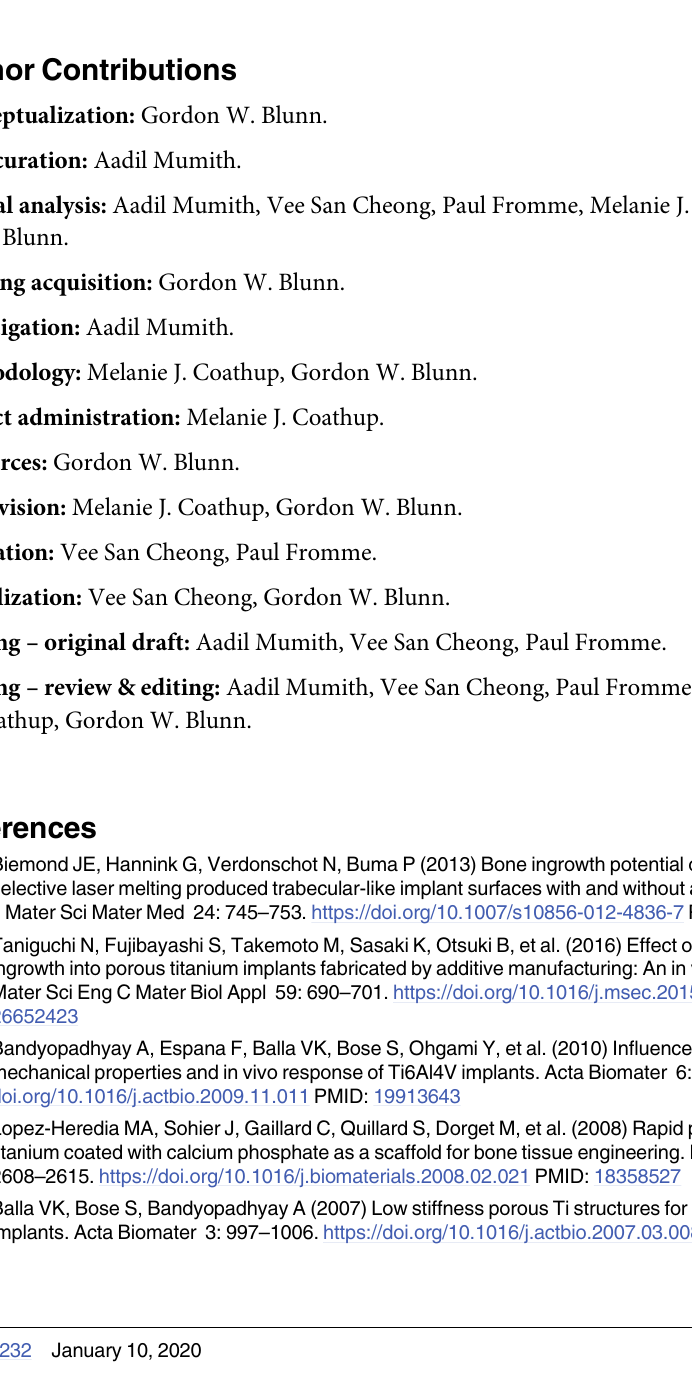
S2 Table. Summary of surface roughness (Ra; nm) measured from 10 mm diameter and 3mm thickness discs. S3 Table. Quantification of ovine mesenchymal stem cells (MSCs) using AlamarBlue assay. S4 Table. Quantification of osteogenic differentiation of ovine mesenchymal stem cells (MSCs) for all coatings on 10 mm diameter and 3mm thickness discs.